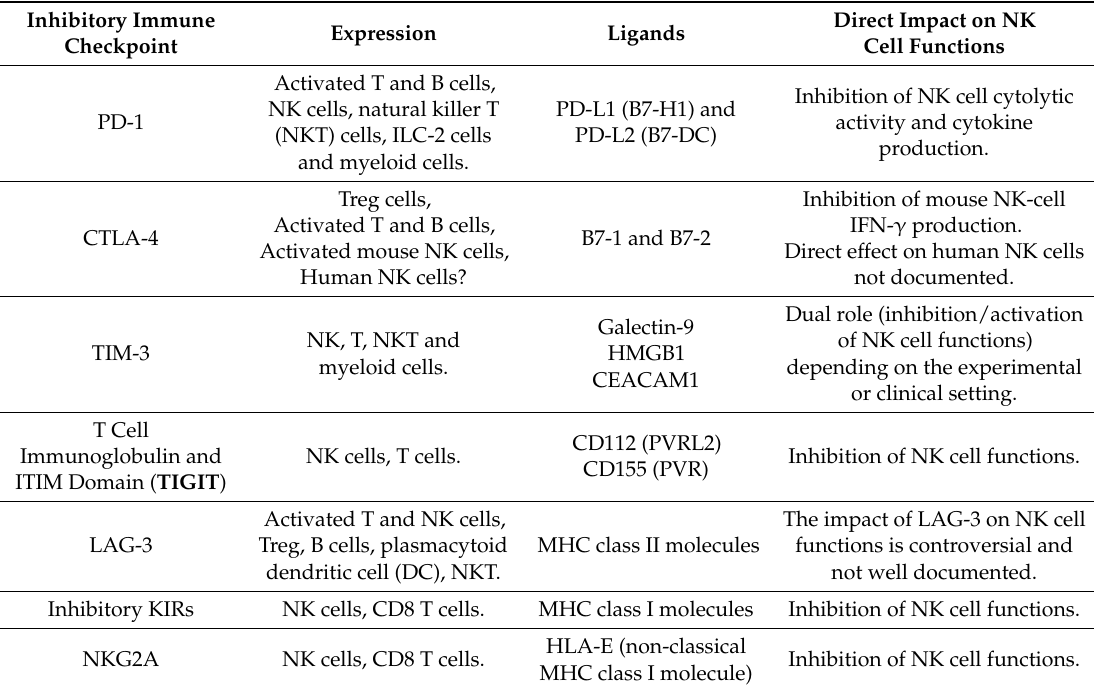
Table 1. Overview of immune checkpoint molecules expressed on natural killer (NK) cells: pattern of expression, ligands, and impact on NK cell